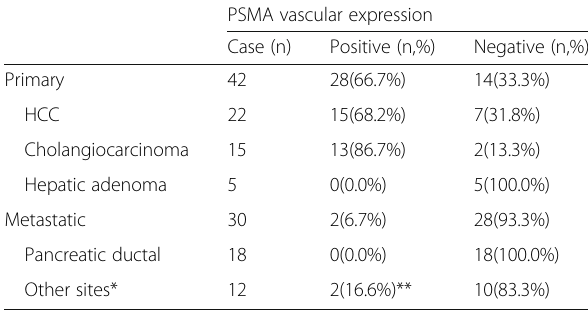
Table 1 PSMA vascular expression in primary and metastatic tumors